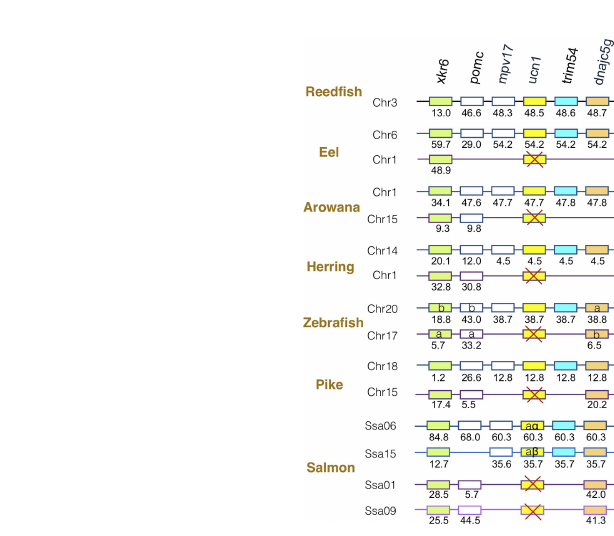
FIGURE 4 | Synteny of ucn1 genomic region in actinopterygians. Ucn1 gene neighborhood is compared between teleost representatives, eel, arowana, herring, zebra fi sh, pike and salmon. The polypteriform actinopterygian, reed fi sh, was used as model of the gene arrangement prior the teleost genome duplication 3R. Chromosomes are indicated by Chr or Ssa for salmon. Gene position are indicated under the genes. Loss of ucn1 gene is indicated with a red cross. Neighboring genes non-represented are considered as lost. Gene references are presented in Table S3 . Letters a and b indicate the 3R-teleost duplicated paralogs and the symbols a and b the 4R-salmonid duplicated paralogs. Members of gene families conserved on the vertebrate tetraparalogon (issued from 1R/2R WGD) are with the same color in Figures 2 – 3